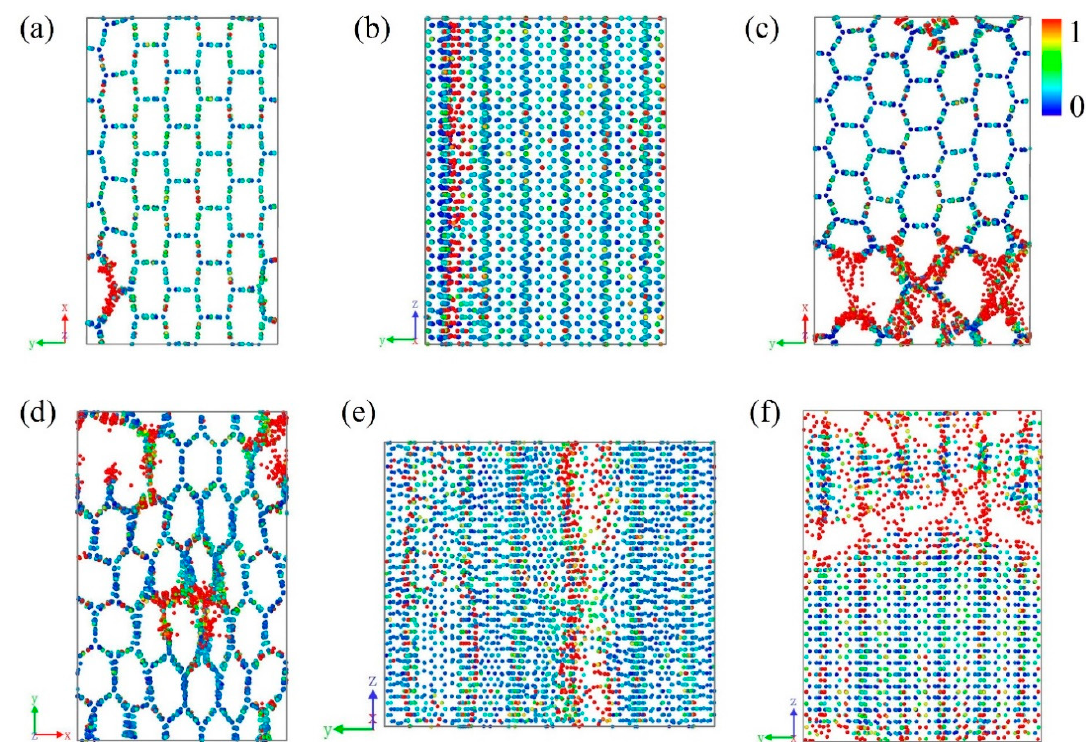
Figure 3. Shear strain. ( a – c ) Evolution of local shear strains for loading along zigzag direction. ( d – e ) Evolution of local shear strains for loading along armchair direction. ( f ) Distribution of local shear strains for loading along cell axis direction.